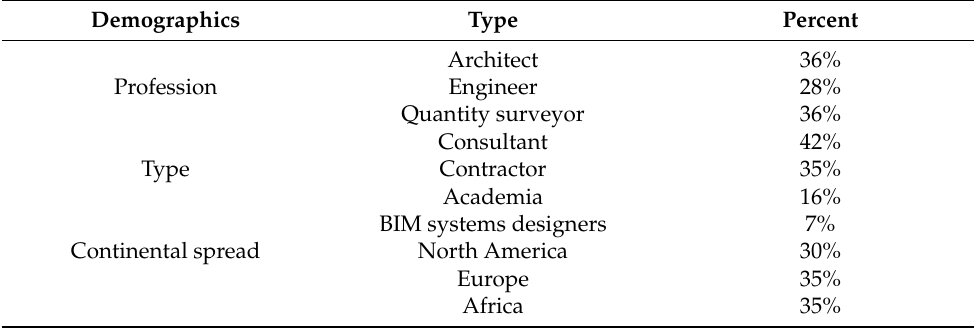
Table 4. Distribution of